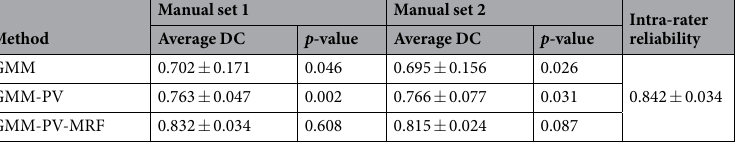
Table 6. Average Dice coefficients (DCs) ( ± standard deviations) for automatic segmentation of myelin-like signals in brainstem of eight test subjects with respect to two sets of manual annotations compared to the intra- rater reliability. The p -values indicate the outcomes of two-tailed Student’s t -tests with the intra-rater DCs at the 5% significance level. The performance of GMM-PV-MRF is close to the intra-rater